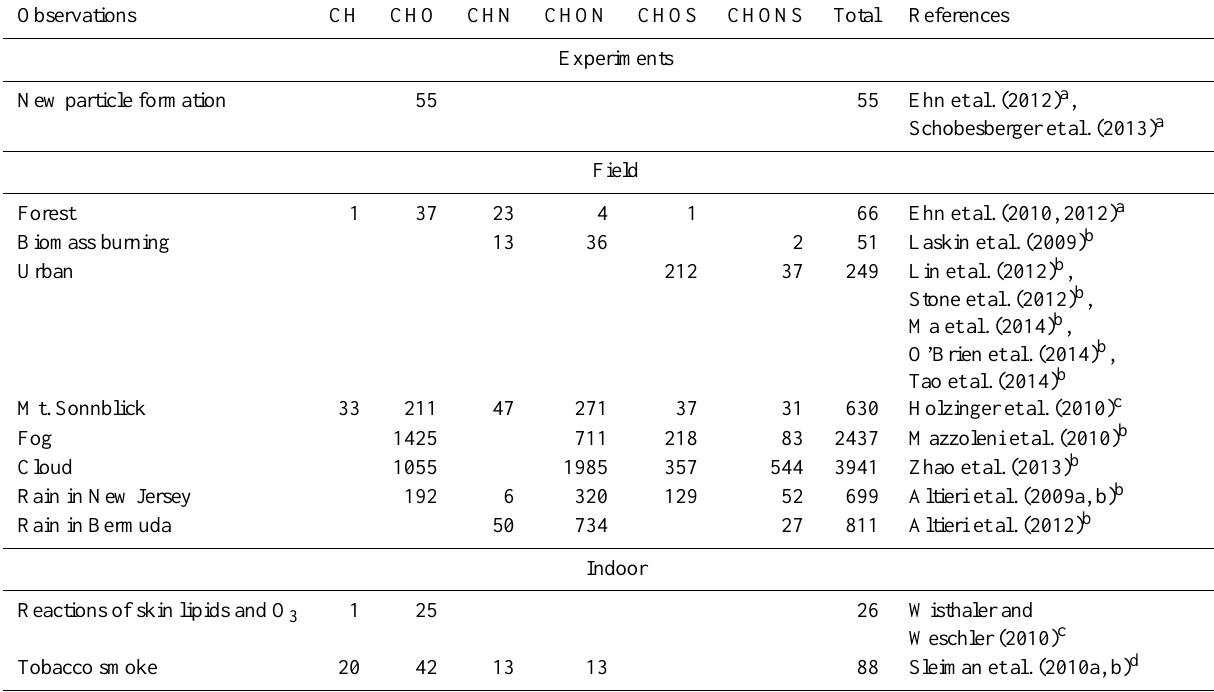
Table 2. Summary of the number of organic compounds in the composition classes (CH, CHO, CHN, CHON, CHOS, and CHONS) measured in 11 observation